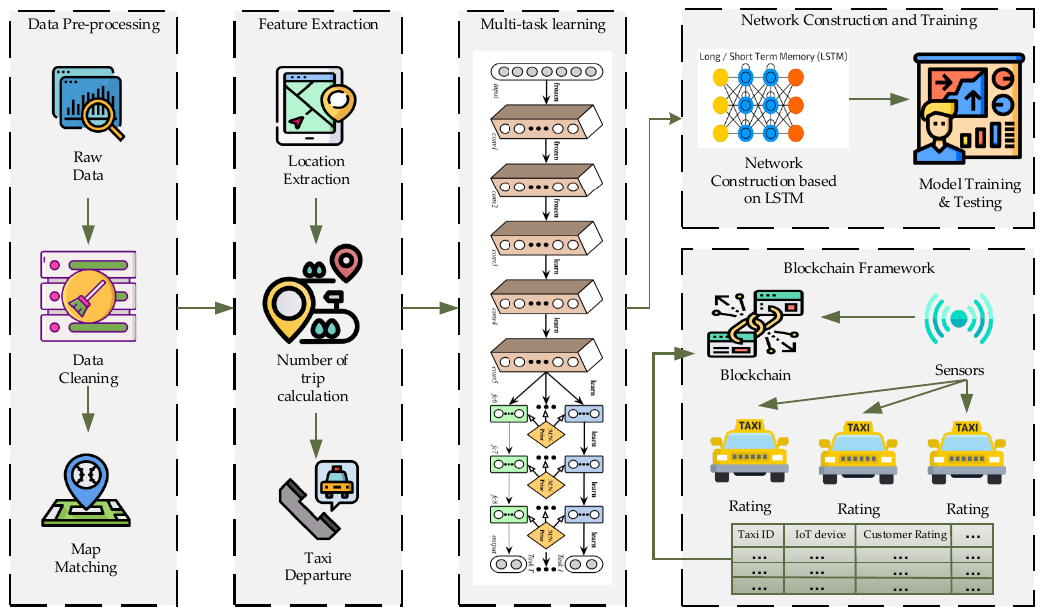
Figure 3. Framework of the proposed